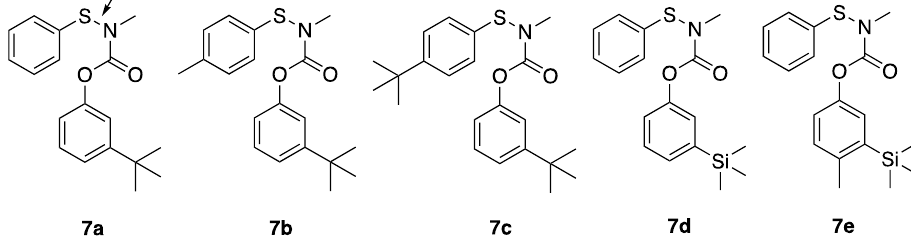
Figure 3. N -sulfenylated pro-insecticidal analogs of 3- t -butyl-phenyl- and 3-trimethylsilyl-phenyl methylcarbamates.